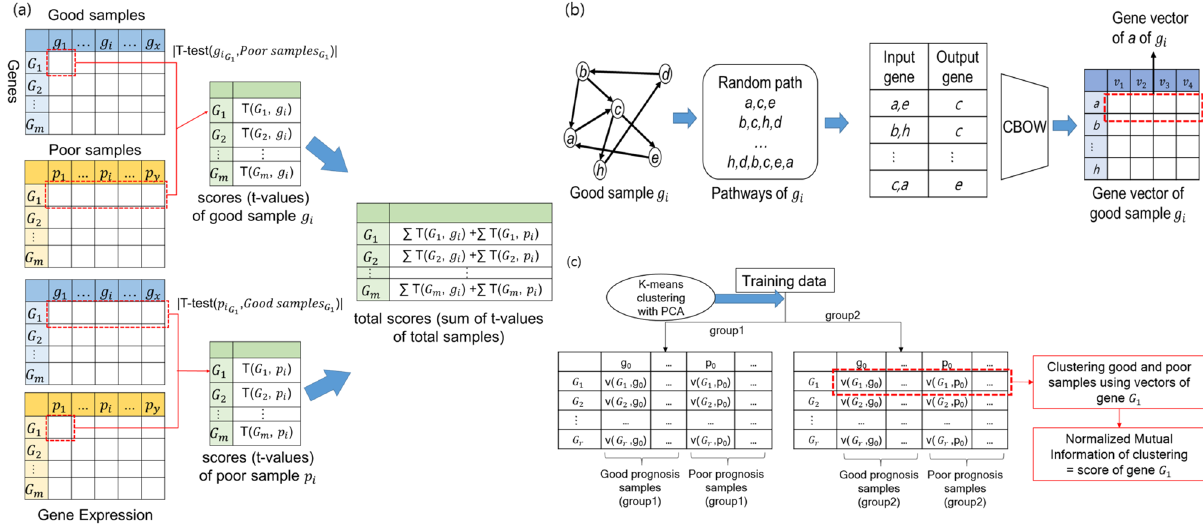
Figure 7. Detailed procedure for each step (a) gene scores are calculated using t-test for each sample, (b) for each sample, gene paths are generated through random walk on FI network of which genes are scored. Generated gene paths are fed into CBOW model to obtain gene vectors, (c) samples are clustered to reduce heterogeneity to form groups by k -means and PCA, and then re-clustered within each group using their gene vectors to calculate normalized mutual information for each